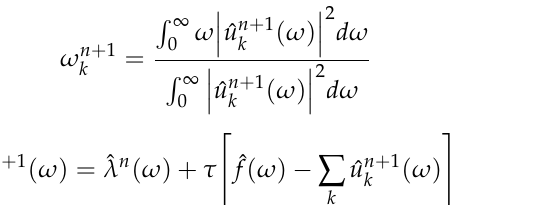
learning algorithms such as backpropagation (BP). The detailed theoretical background of ANN can be found in Alpaydin [32].